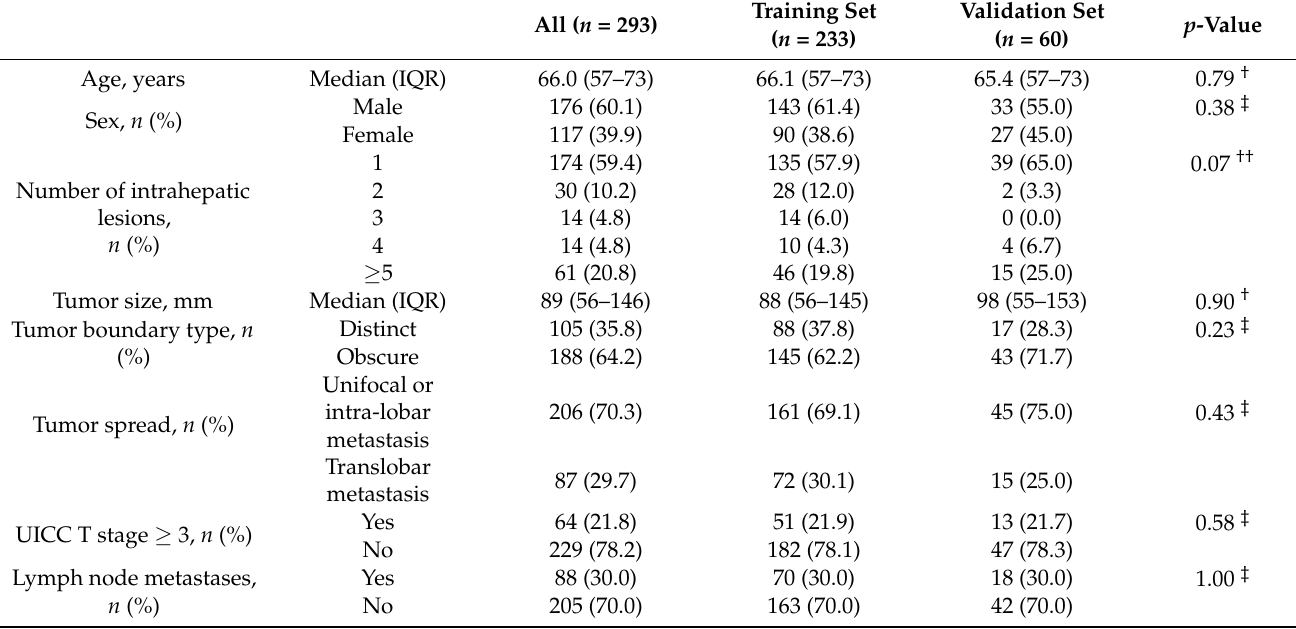
Table 1. Baseline characteristics of the patient